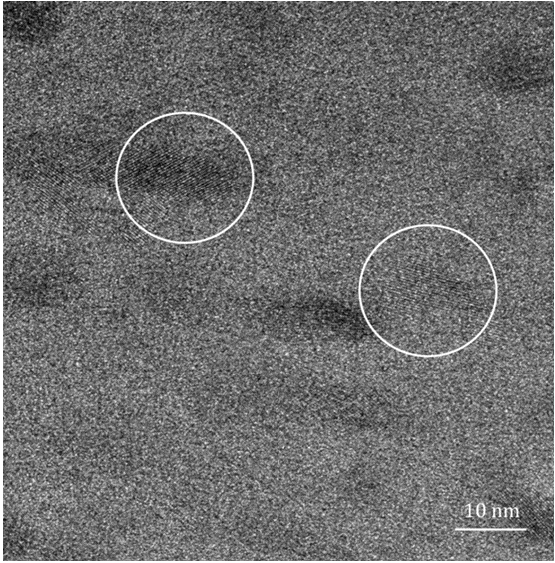
Figure 6. TEM bright field emission image of the grains of the silicon and the silicon carbide layers showing some crystallinity within the white circles.